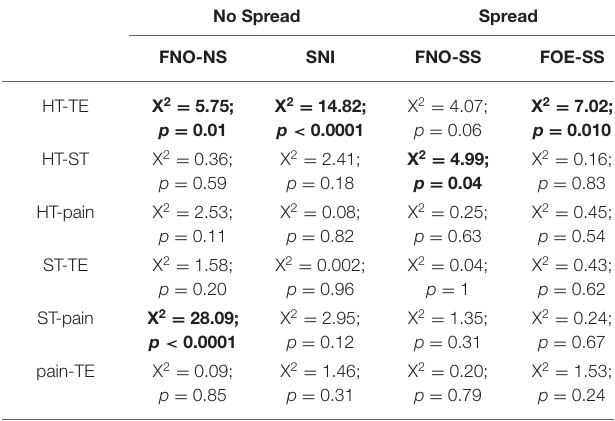
TABLE 2 | Associations between motor and sensory